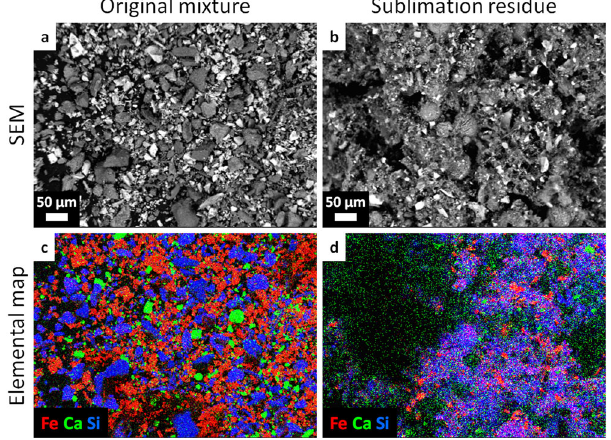
Fig. 6 Mineral distribution in the Ceres analogue sample, pre-and post- sublimation. SEM (backscattered electrons) images ( a , b ) and corresponding elemental maps ( c , d ) of the original Ceres analogue material ( a , c ) and the sublimation residue ( b , d ). The elements Fe, Ca, and Si are mapped in red, green, and blue, respectively. The 3D-structure of the residue leads to some parts of the scene in b not registering in the elemental map d